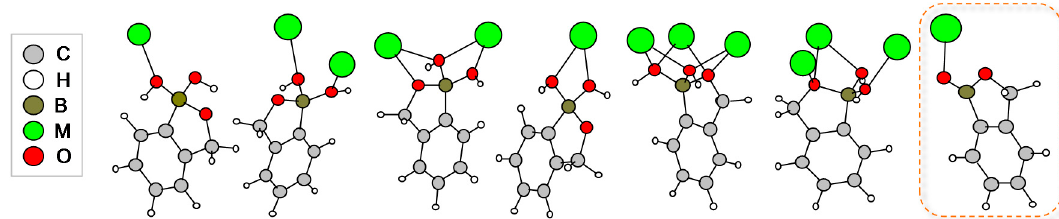
Figure 8. Coordination modes of the simplest benzoxaborolate ligand with respect to alkaline earth metals (M = Mg, Ca). The deprotonated benzoxaborolate found in the Ca structure is outlined in dashed orange. Adapted with permission from [27] (copyright American Chemical Society, 2015).